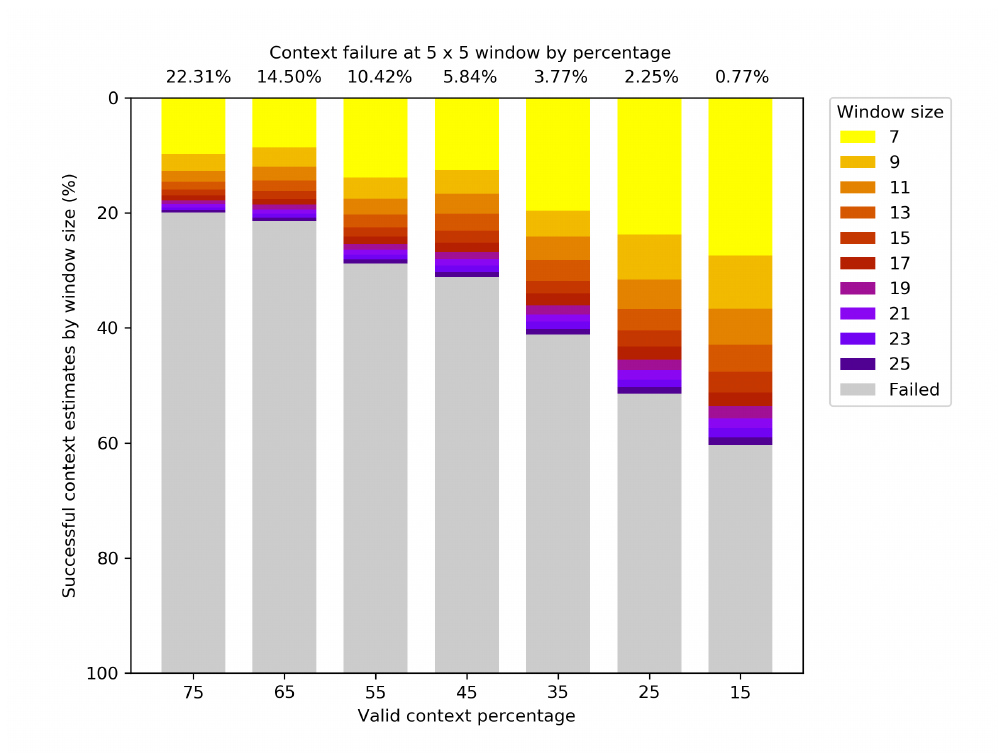
Figure 5. Breakdown of the temperature estimation pass rate on pixels that have no solution in their 5 × 5 window. The percentage of pixels covered by each bar in this figure, as a portion of all pixels examined, is shown at the top of the figure. Each bar in the figure represents a minimum percentage level of valid contextual pixels for temperature calculation, and each coloured section represents the portion of pixels that are successful in deriving an estimate at each window size. The balance of exhausted pixels with no solution at each assessed percentage is also